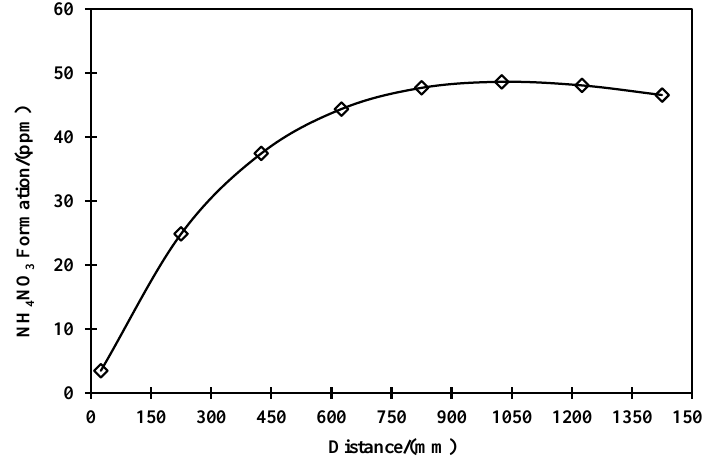
Figure 8. The relationship between the amounts of NH 4 NO 3 produced before the reactor inlet and the distance (T = 150 °C, NO 2 /NO x = 0.25).